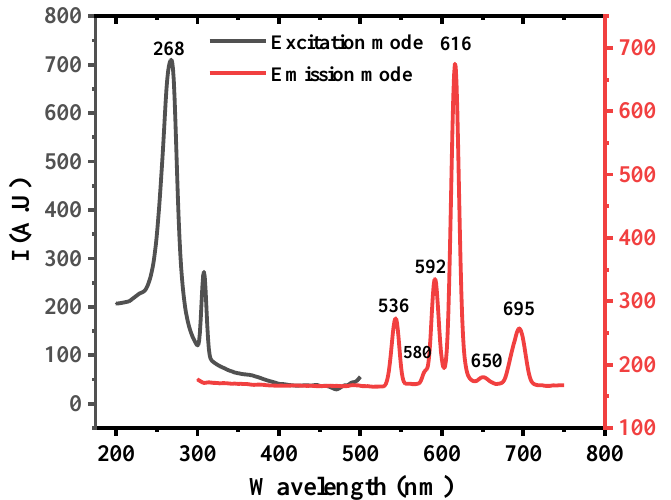
Figure 2. The excitation and emission spectra of the 2.5 × 10 − 5 mol · L − 1 of Eu (III)–(vitB1) 2 complex in methanol at room temperature ( λ ex/em = 268/616 nm). (The red numbers scale for the emission spectra)